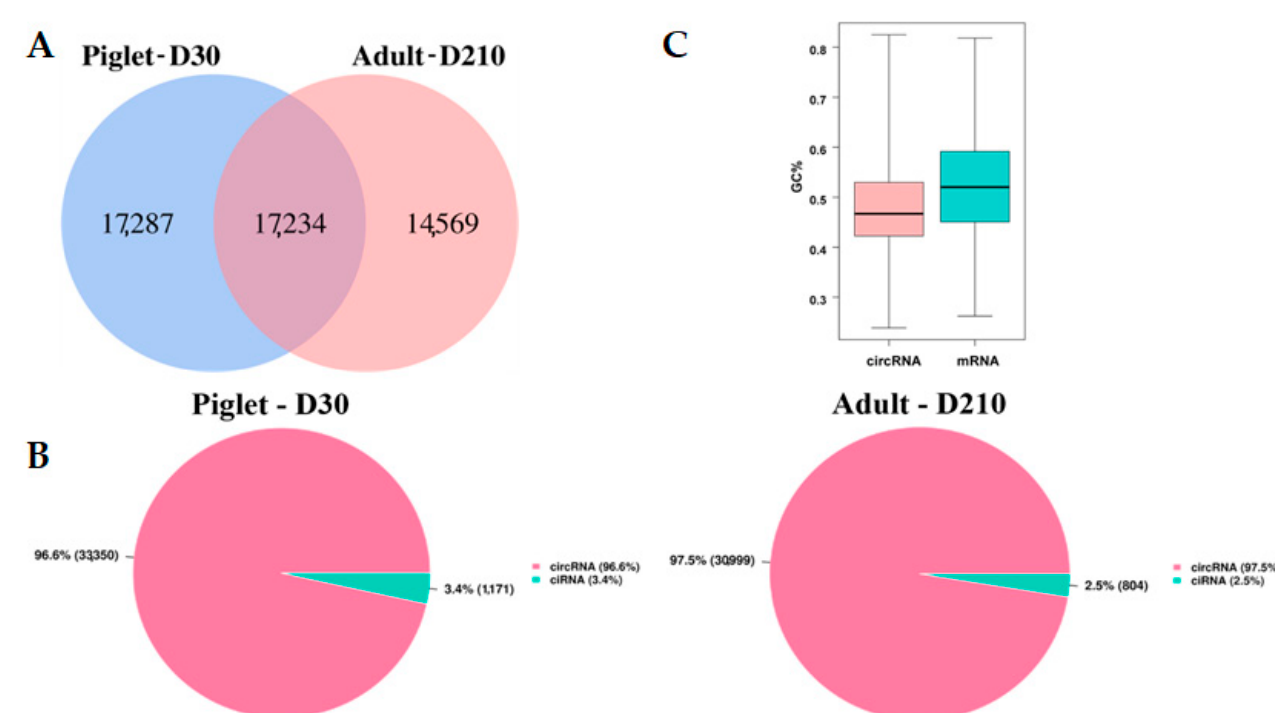
Figure 2. Basic characteristics of circRNAs in the testes of young (Piglet-D30) and sexually mature (Adult-D210) boars. Venn diagram showing the amount of circRNA expression in the testes tissues of young and sexually mature Landrace boars ( A ). Distribution of circRNA types in the testis tissue of young and sexually mature Landrace breeding boars. All circRNAs are divided into two types: exon circRNA, and intron circRNA (ciRNA) ( B ). GC contents of circRNA obtained from sequencing compared with the GC contents of mRNA in the database ( C ).